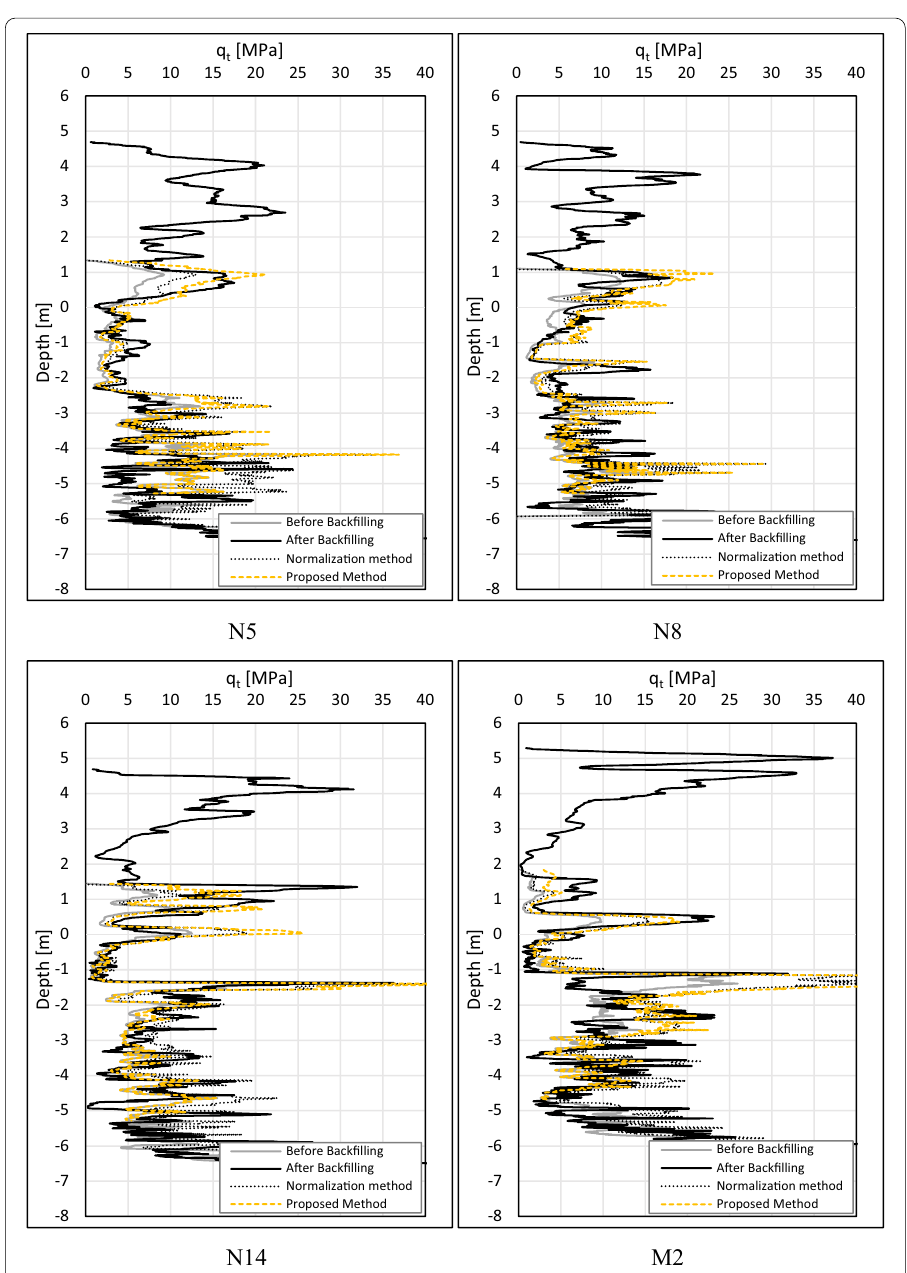
Fig. 5 Solid gray and block curves show the q t values of pre and post CPTs ( q t , pre and q t , post ). Dotted and dashed curves present the prediction of q t , post using the normalization method and the methods